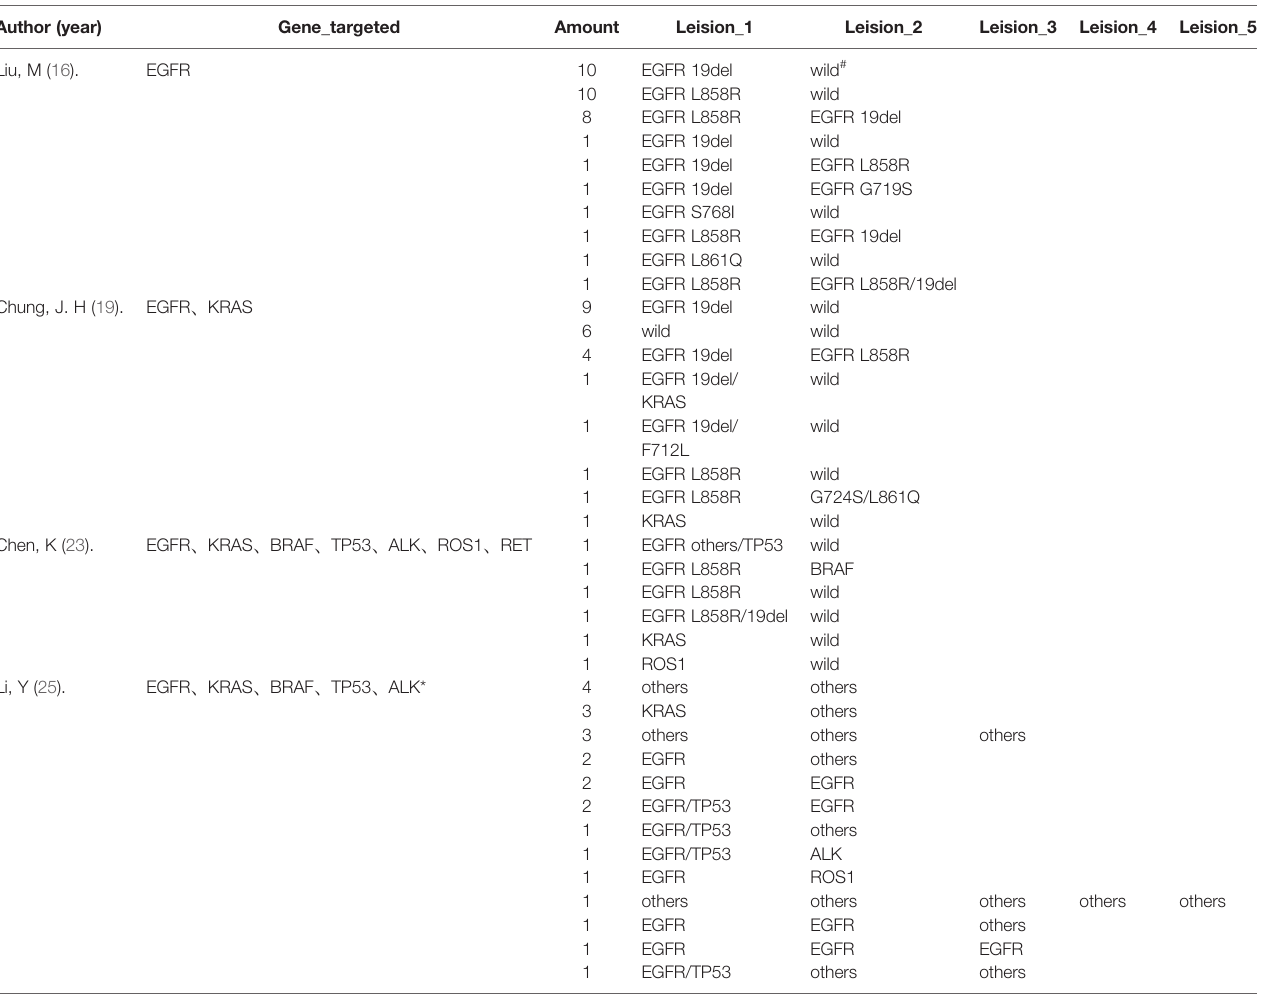
TABLE 3 | Gene mutations in synchronous multiple ground-glass nodules (SMGGNs). TABLE 3A Data extracted from four articles which showed the gene alterations among multicentric SMGGNs. Author (year) Gene_targeted Amount Liu, M (16).